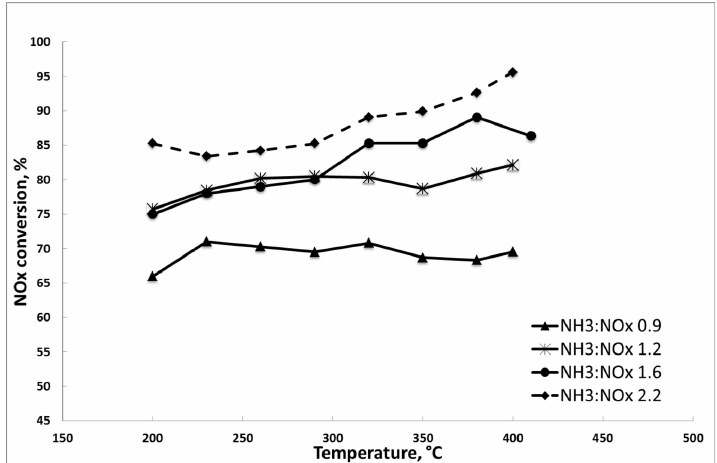
Figure 3. Effect of the temperature on NOx conversion at different NH 3 /NOx ratios for V 2 O 5 /TiO 2